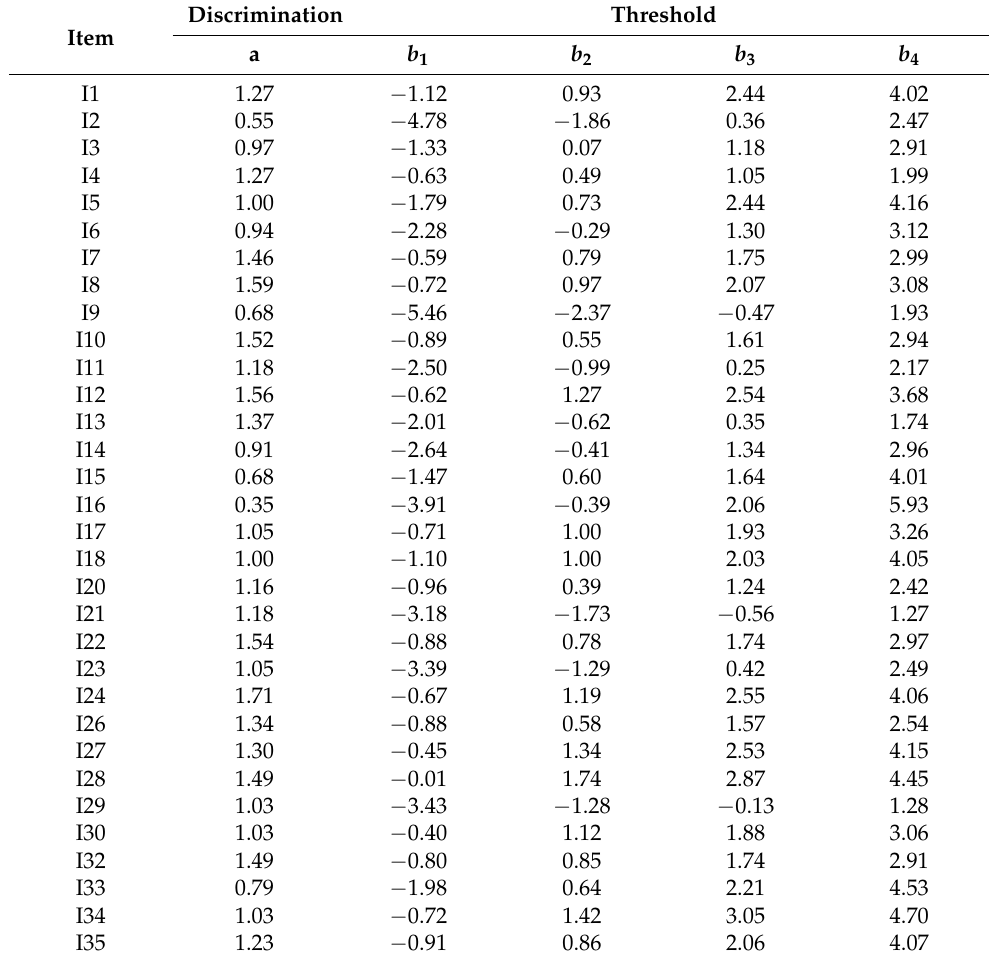
Table 4. Parameter estimates of the initial Chinese version of D scale (D32-C) based on